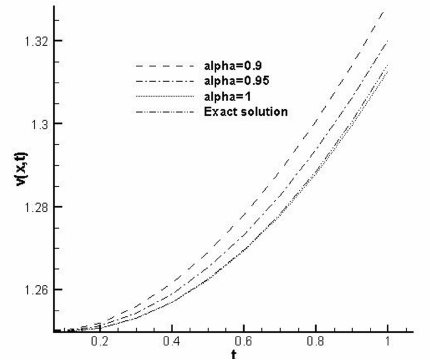
Fig. 4. Solution of Eq. (23) using the 2-iteration of DJM for different values of α when, x=0.1